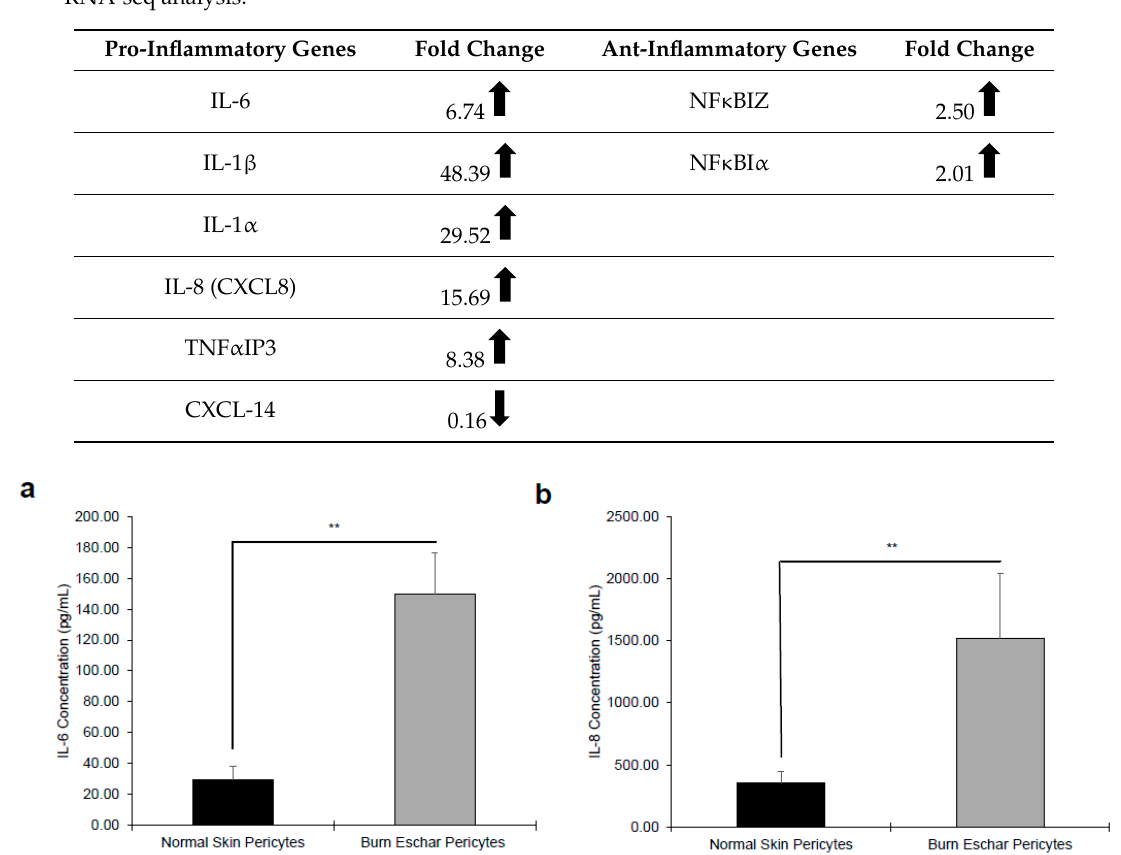
Figure 3. Burn Eschar pericytes express high levels of pro-inflammatory cytokines. ELISA analysis of ( a ) IL-6 and ( b ) IL-8 expression by normal and burn eschar pericytes. ELISA analysis was performed using normal skin pericytes derived from three di ff erent patients and burn eschar pericytes derived from four di ff erent patient samples. The results indicate that pericytes isolated from the burn eschar express significant higher amounts of the pro-inflammatory cytokines IL-6 and IL-8 compared to normal pericytes. Statistical analysis was performed using ANOVA with p < 0.05 considered statistically significant. Data is represented as mean ± SEM values. ** p < 0.01. Interleukin- 1alpha (IL-1 α ); Tumor necrosis factor alpha-induced protein 3 (TNF α IP3); chemokine ligand- 14 (CXCL-14); nuclear factor of kappa light polypeptide gene enhancer in B cells inhibitor, zeta (NF κ BIZ); nuclear factor of kappa light polypeptide gene enhancer in B cells inhibitor, alpha (NF κ BI α ).